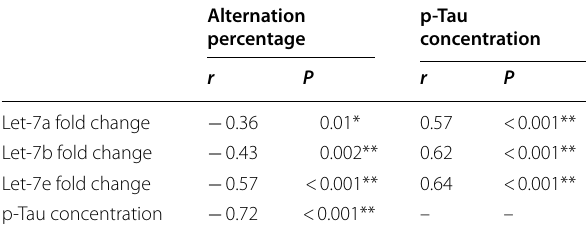
Table 6 Correlations between alternation percentage, p‑Tau concentration and Let‑7 miRNAs